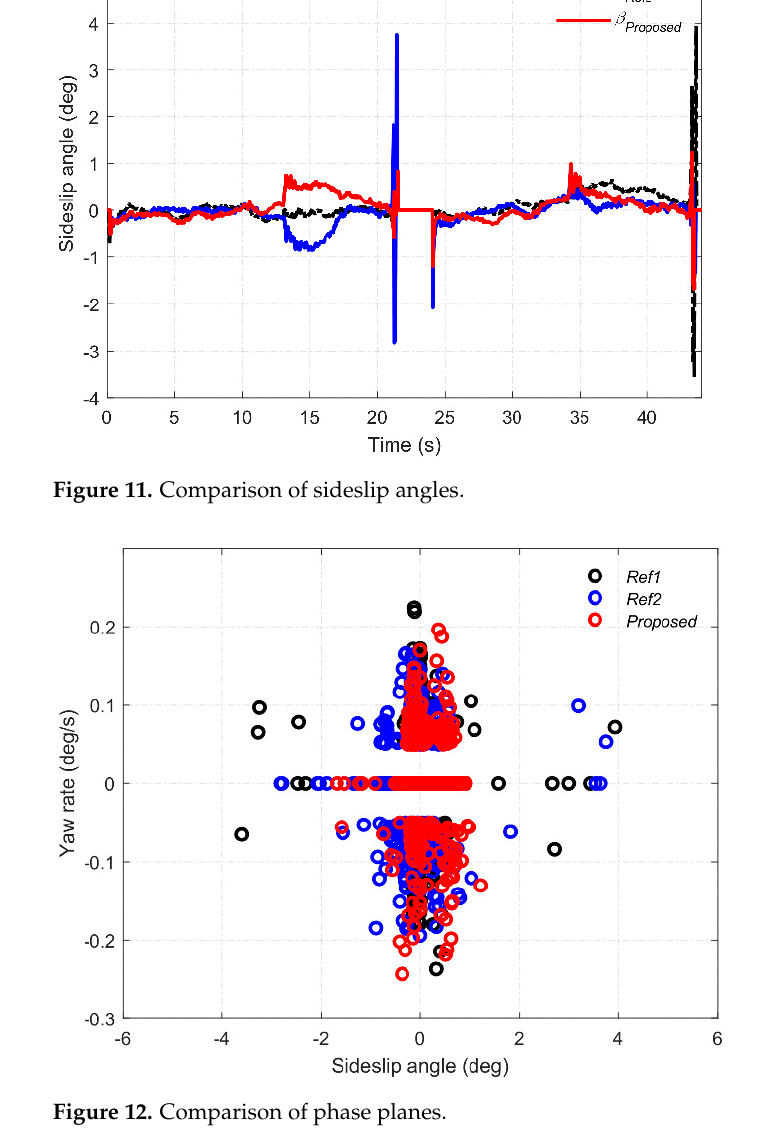
Figure 13. The desired yaw rate was set to 2.87 degrees/s from 3 to 11 s and 0 in other periods.